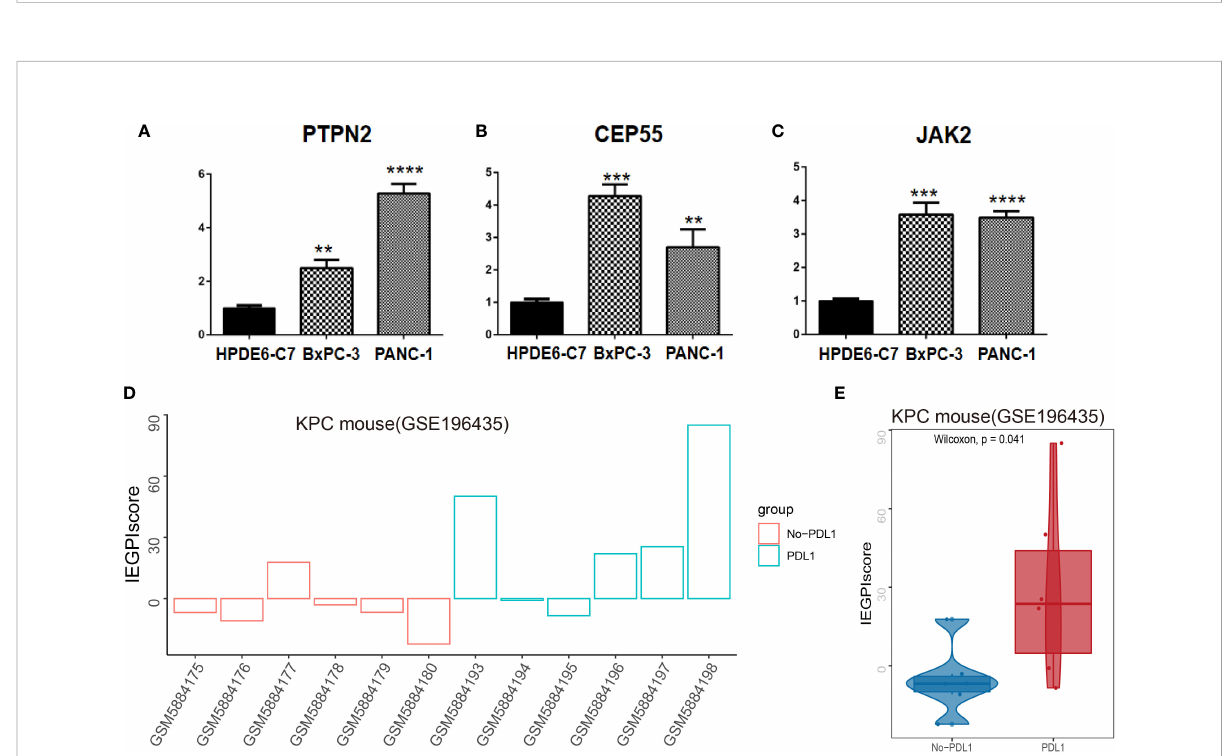
FIGURE 7 Validation of IEGPI score in cell lines and KPC mouse model. RT-PCR for represented IEGPI genes in HPDE6-C7, BxPC-3 and PANC-1. (A) PTPN2, (B) CEP55, (C) JAK2. (D) IEGPI score expression of each sample in the KPC mice model with and without PDL1. (E) differences of IEGPI score between the KPC mice model with and without PDL1. **P <0.01, ***P <0.001, ****P <0.0001.